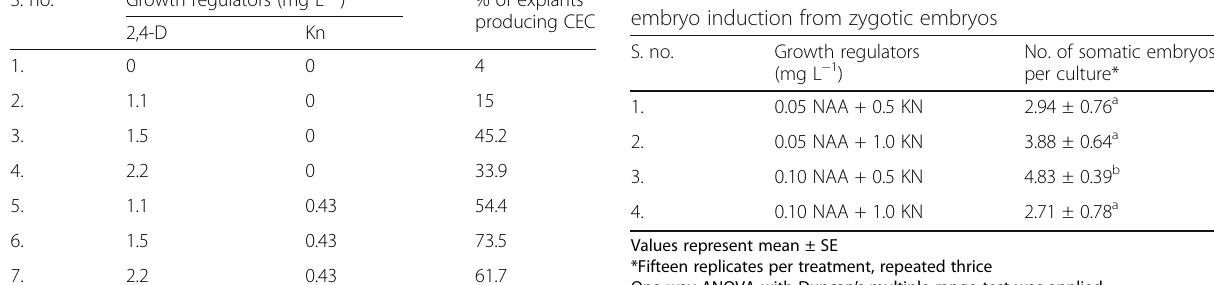
Table 2 Effect of NAA and kinetin concentration on somatic embryo induction from zygotic embryos